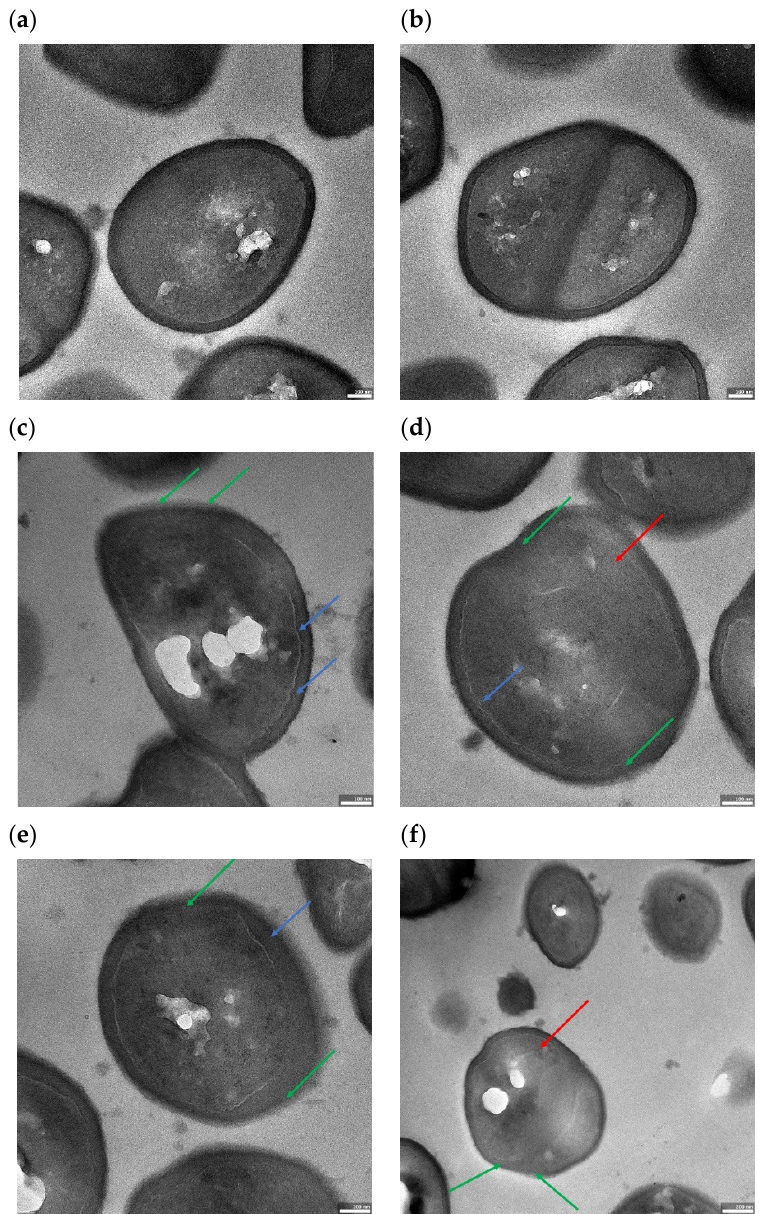
Figure 9. Transmission electron microscopy cross-section of ( a , b ) MRSA 1 cells unexposed to the RMF; ( c – f ) MRSA 1 cells exposed to the RMF (5 Hz). Red arrows indicate deformation of shape of staphylococcal cells after exposure to RMF. Green arrows indicate loss of cell wall density after exposure to RMF. Blue arrows indicate contraction of cytoplasm after exposure to RMF. Scale bars represent 100 nm (picture a – e ) and 200 nm (picture f ). Magnified regions of interest are additionally presented in Supplementary Figure S9. The cellular shapes of ca. 400 nm diameter seen in the image 9f are staphylococcal cells cut in their apex